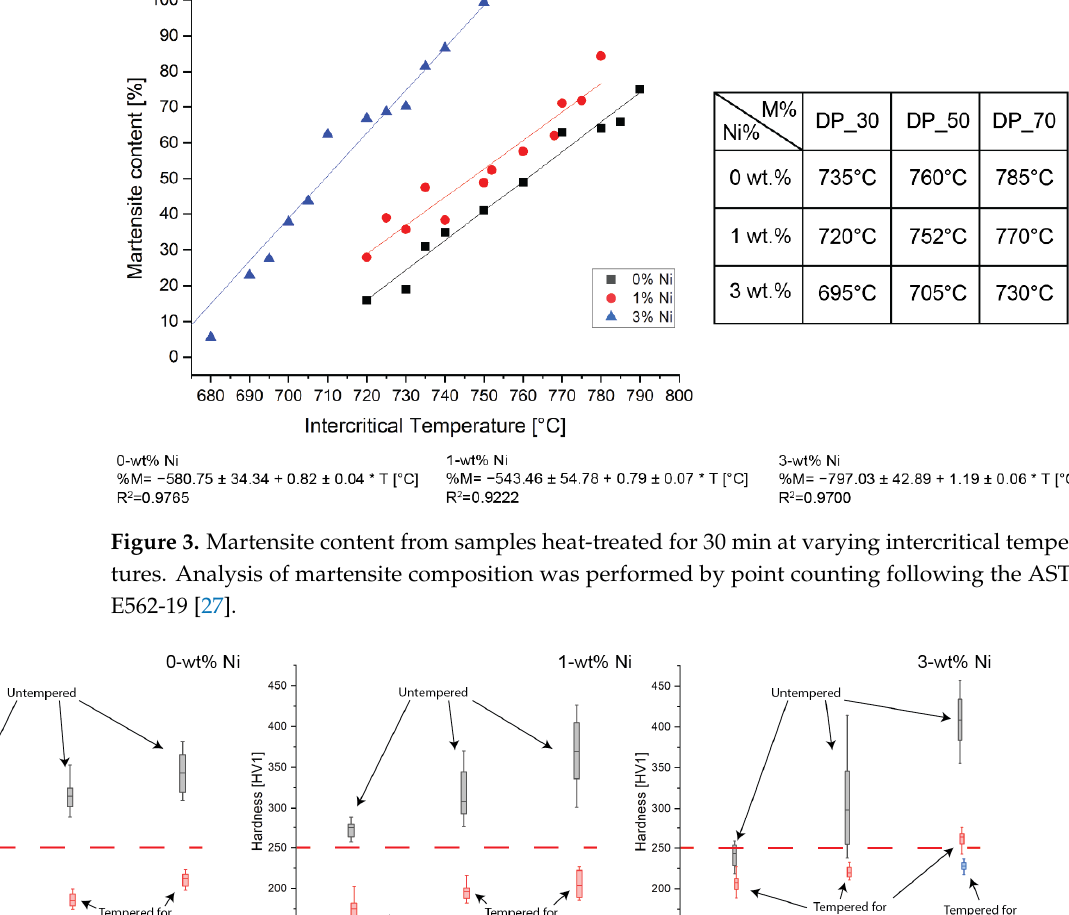
Figure 5. Scanning electron micrographs of 1-wt% Ni DP_70% in the as-quenched condition ( A ) and after temper ( B ). Untempered martensite displays a needle and rough appearance while ferrite is present as a smooth area. Tempered microstructure displayed carbides at boundaries and within martensitic laths. 3.2. Quantification of Retained Austenite by XRD Figure 6 illustrates the diffraction pattern of the 3-wt% Ni DP_70% sample, in which the characteristic patterns for body-centered cubic (BCC) and FCC are displayed in red and blue, respectively, and labelled. The peaks matching red lines corresponding to BCC